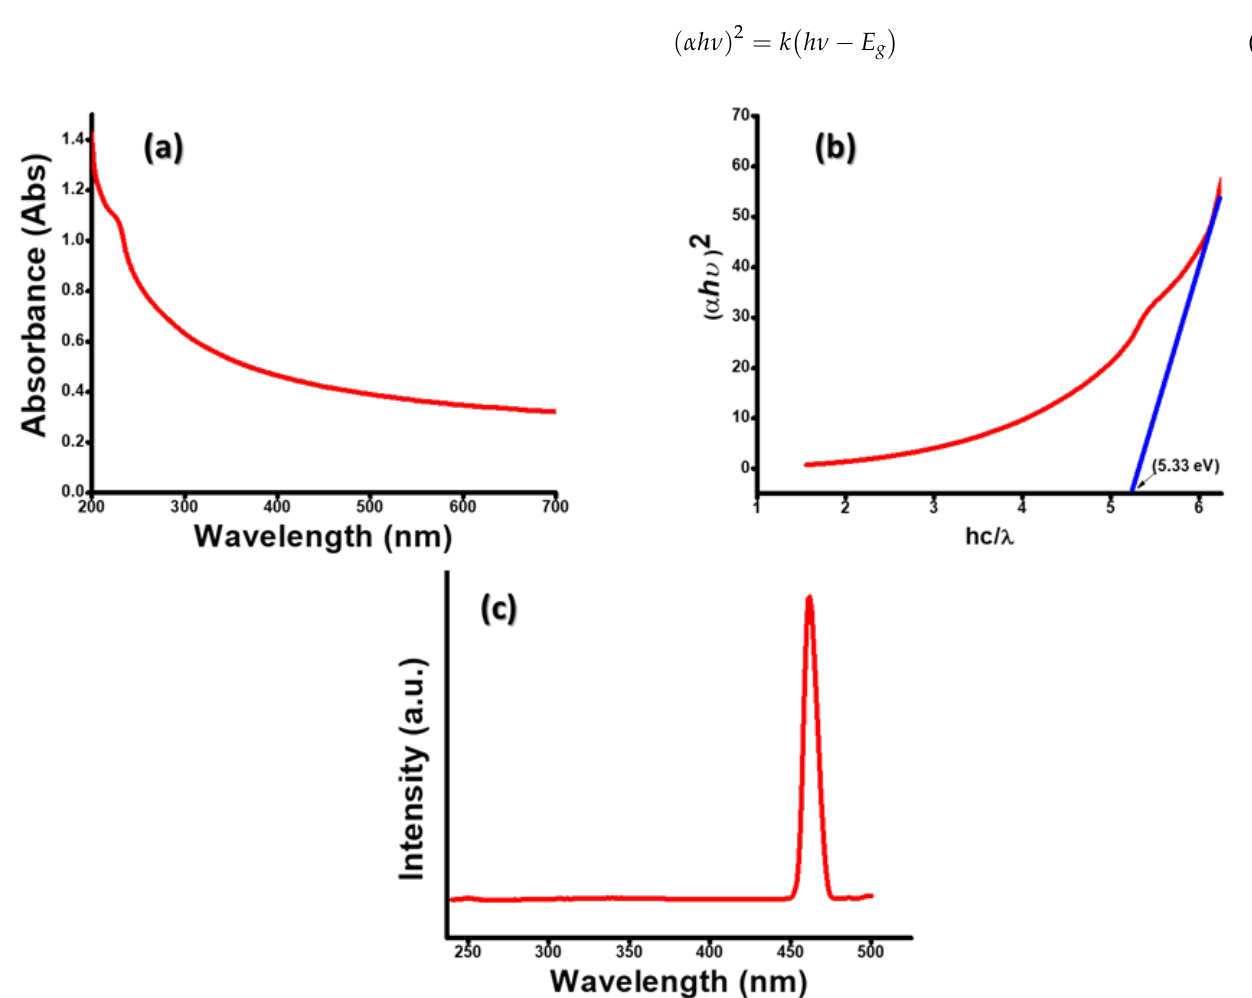
Figure 3. ( a ) UV/Vis spectrum; ( b ) Tauc’s plot; ( c ) fluorescence spectrum of Gd 2 O 3 NPs.